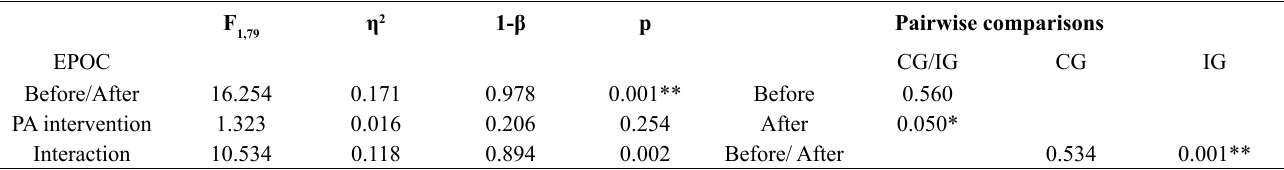
Table 4. Statistics obtained for excess post-exercise oxygen consumption